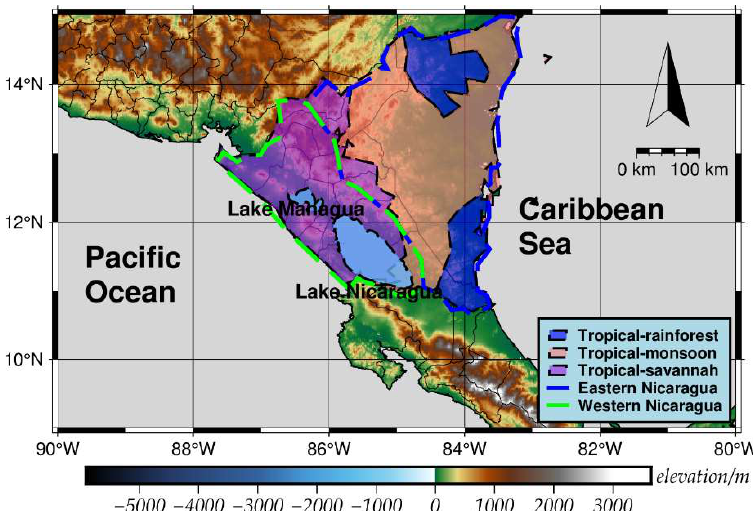
Figure 1. Map of Nicaragua. The climate classification is based on the Köppen–Geiger climate clas- sification [29]. classification